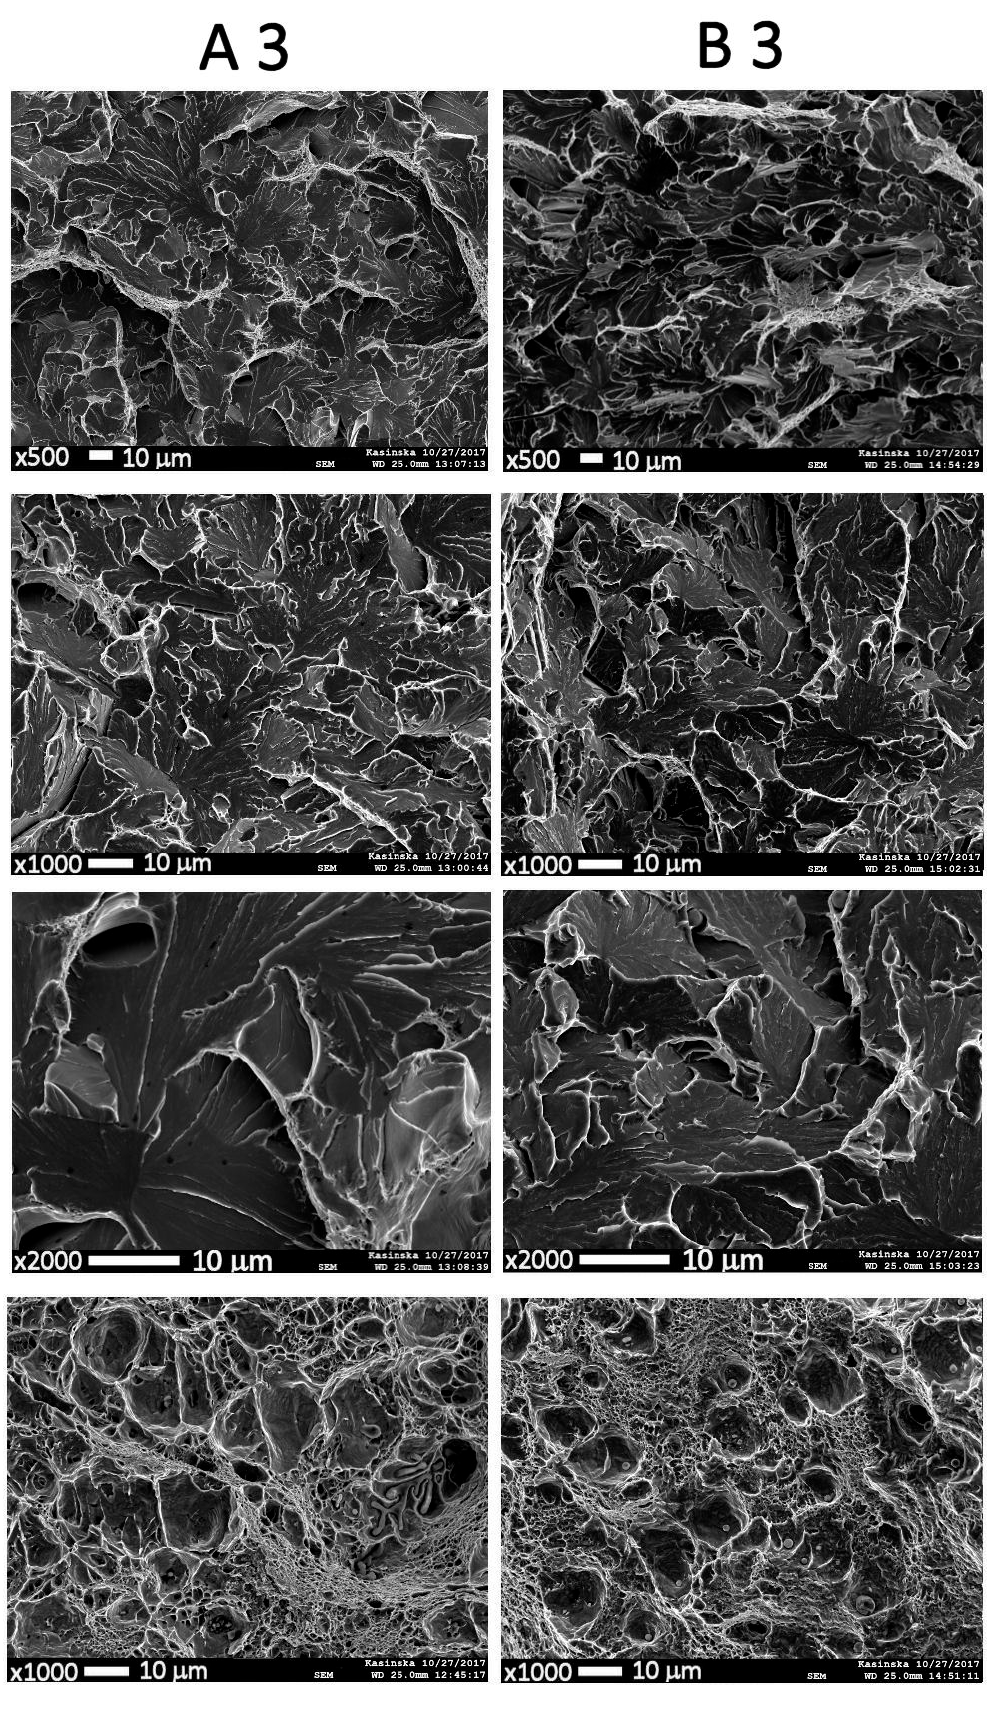
Figure 13. Morphology of A3 and B3 fracture surfaces.